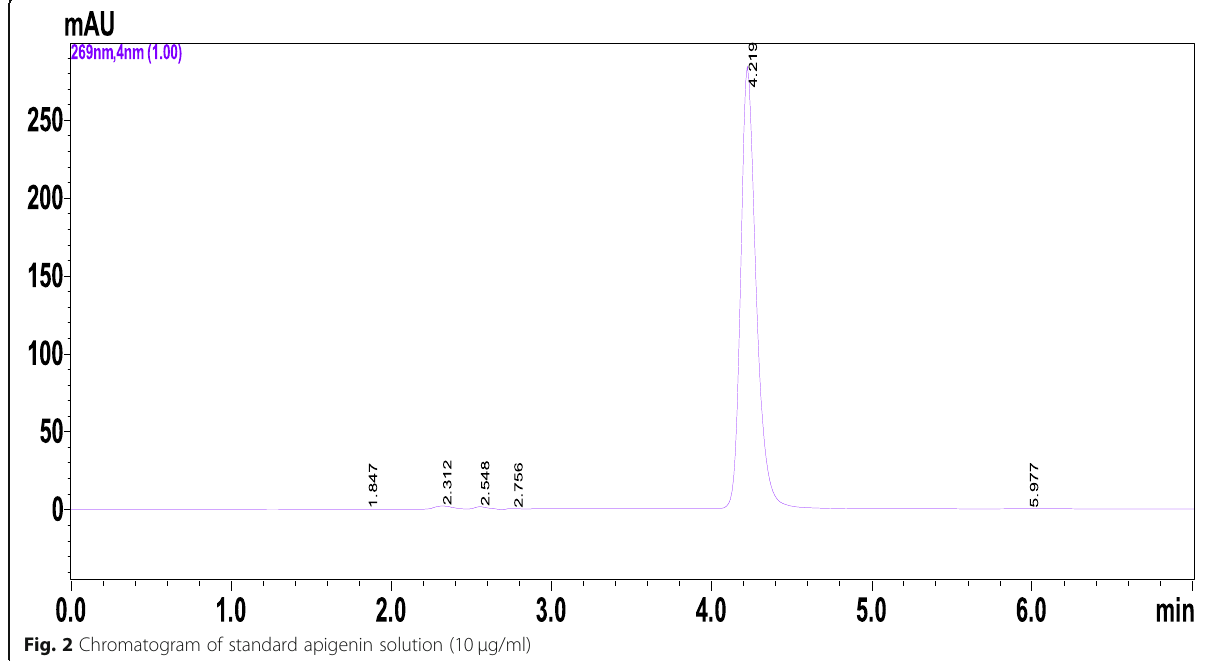
Fig. 2 Chromatogram of standard apigenin solution (10 μ g/ml)